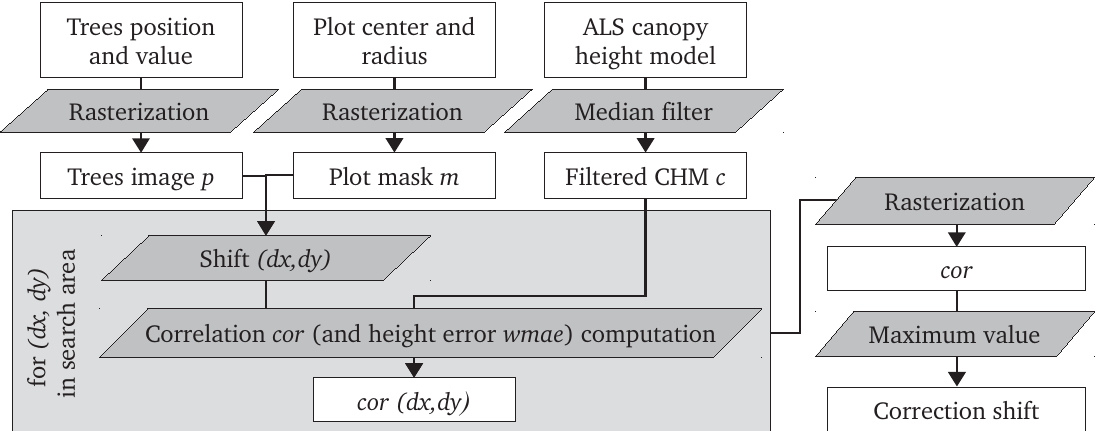
Figure 2. The workflow for the co-registration of a forest plot with the correlation ( cor ) method. For the weighted mean absolute error ( wmae ) method, the workflow is similar, except that the minimum value is used to select the correction